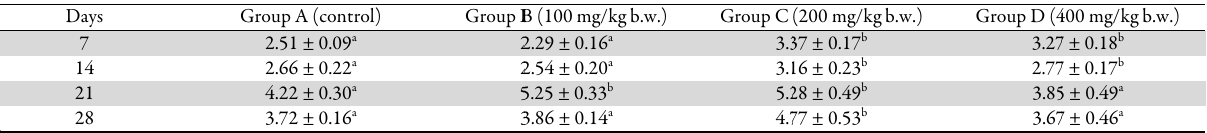
Different superscripts across a row indicates significant differences between the means ( Table 6. Mean serum cholesterol (mg/dl) levels (means ± standard error) of rat groups administered methanol fruit extract of Days Group A (control) Group B (100 mg/kg b.w.) Group C (200 mg/kg b.w.)